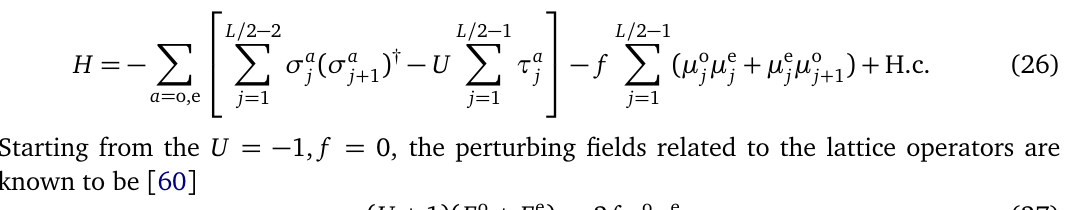
τ + H.c. ) perturbation j j + 1